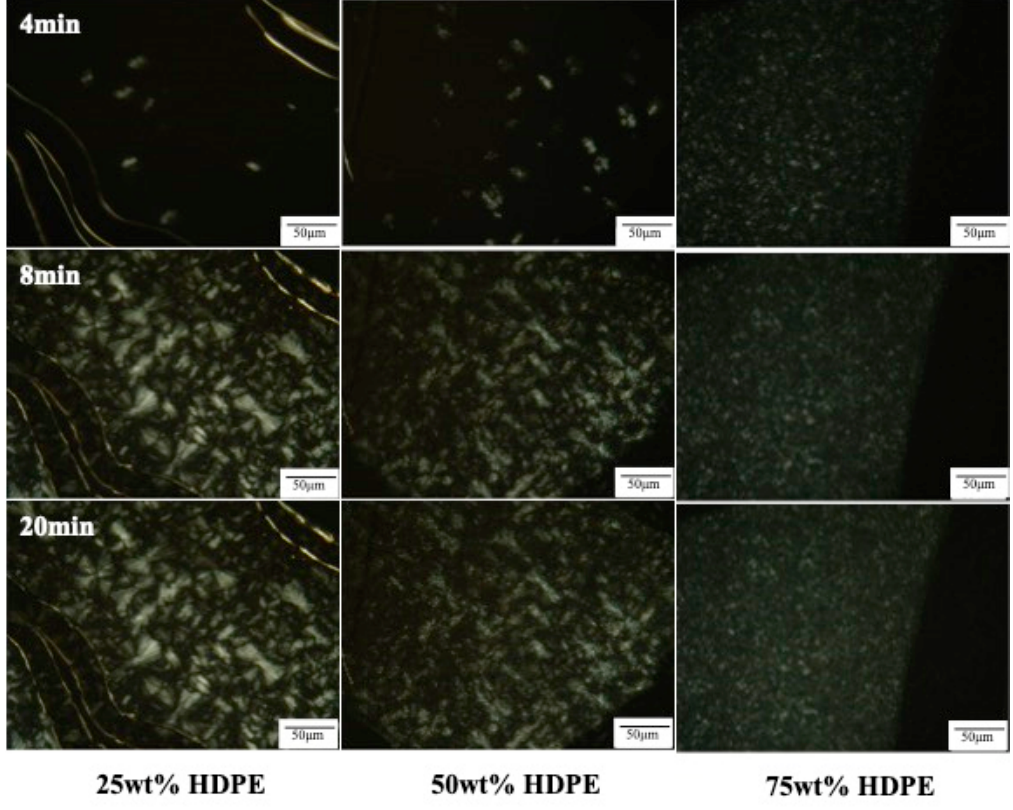
Figure 6. Polarizing optical microscopy of the nucleation and growth process of PP/HDPE blends containing 25 wt % HDPE, 50 wt % HDPE and 75 wt % HDPE during isothermal crystallization at 125 °C.